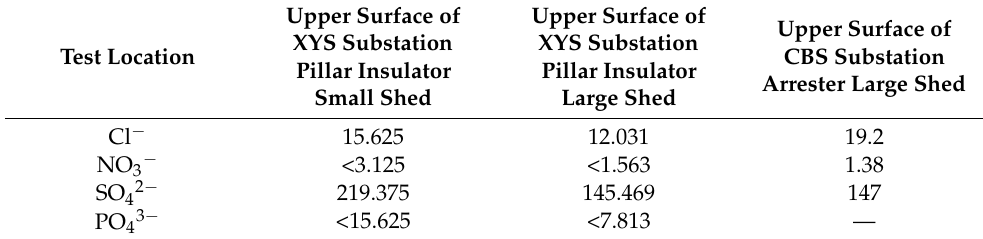
Table 8. The concentrations of cations in contamination solution (mg/L).